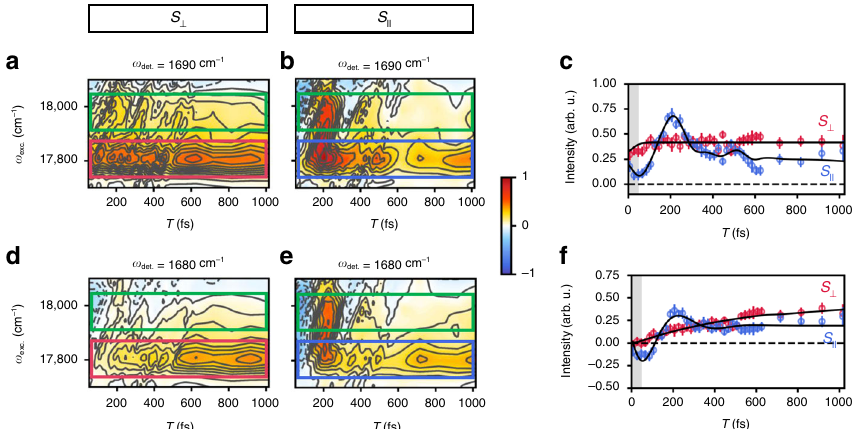
Fig. 2 Ground-state bleach dynamics along the excitation axis. a , b Perpendicular and parallel PA spectral evolution as a function of waiting time along the excitation axis at a fi xed detection frequency of 1690 cm − 1 (indicative of Chl b population). Ground-state bleach features are positive (red) features and excited-state absorption features are negative (blue) features. The frequency region centered around 17,800 cm − 1 is boxed in red for the perpendicular PA component ( S ⊥ ) and blue for the parallel PA component ( S || ). Throughout, green boxes indicate the higher frequency region centered around 18,700 cm − 1 . c Peak amplitude dynamics at a detection frequency of 1690 cm − 1 along 17,800 cm − 1 (through the center of the corresponding boxed regions of the same color). Error bars indicate the estimated errors in the peak amplitude based on the standard deviation of the signal amplitude at each waiting time. The black lines indicate the fi ts of the peak amplitude dynamics (provided in Supplementary Table 1). The gray shaded region indicates the region where pulse overlap effects occur. d , e Same as described for a , b except at a detection frequency of 1680 cm − 1 (indicative of Chl a population). f Same as c except at a detection frequency of 1680 cm − 1